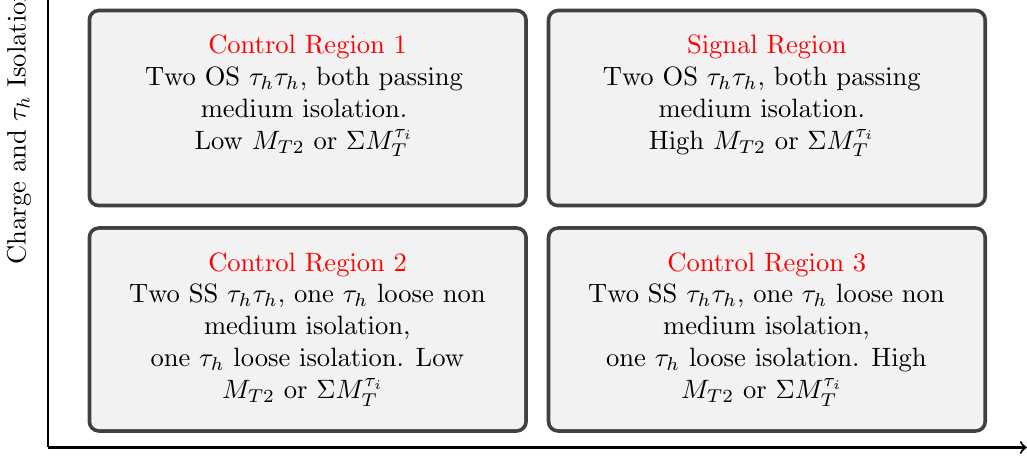
Figure 3 . Schematic illustration of three control regions and the signal region used to estimate the QCD multijet